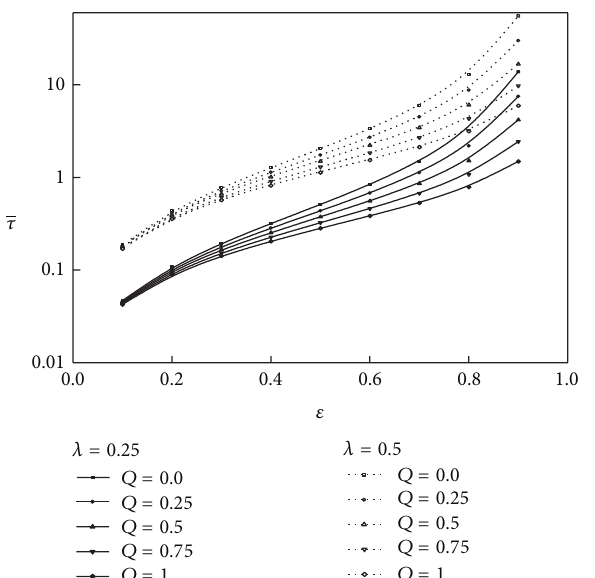
Figure 7: Variation of nondimensional time with eccentricity ratio 𝜀 for different values of 𝑄 with 𝑙 = 0.4 , 𝑁 = 0.2 , and 𝜆 = (0.25, 0.5) .